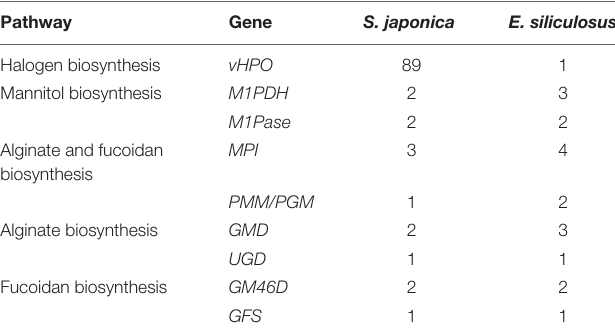
TABLE 4 | Gene copies in the important gene pathways of S. japonica and E. siliculosus .